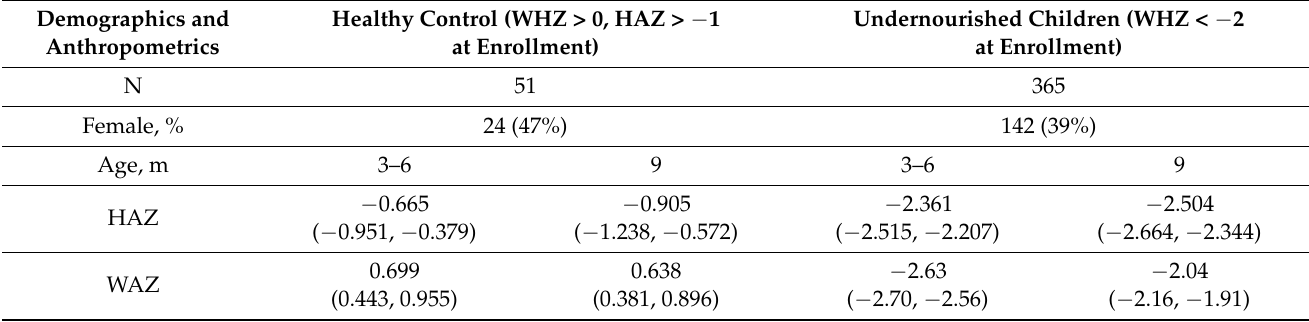
Table 1. Demographics and anthropometrics 1 of Pakistani undernourished and healthy children 2